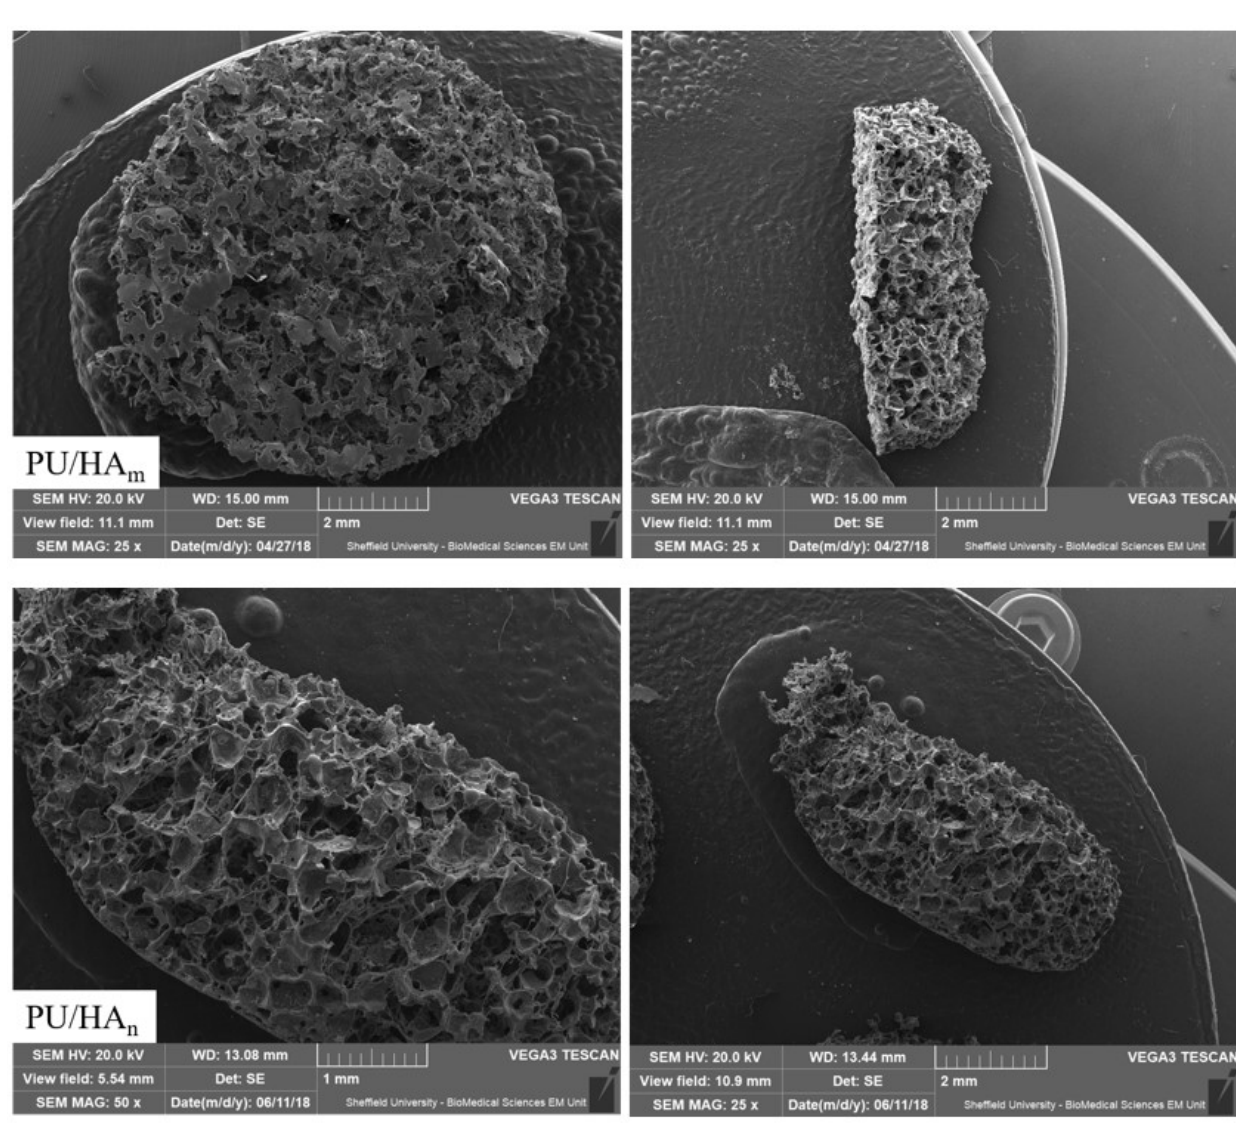
Figure 1. SEM images of PU, PU/HA micro and PU/HA nano scaffolds.